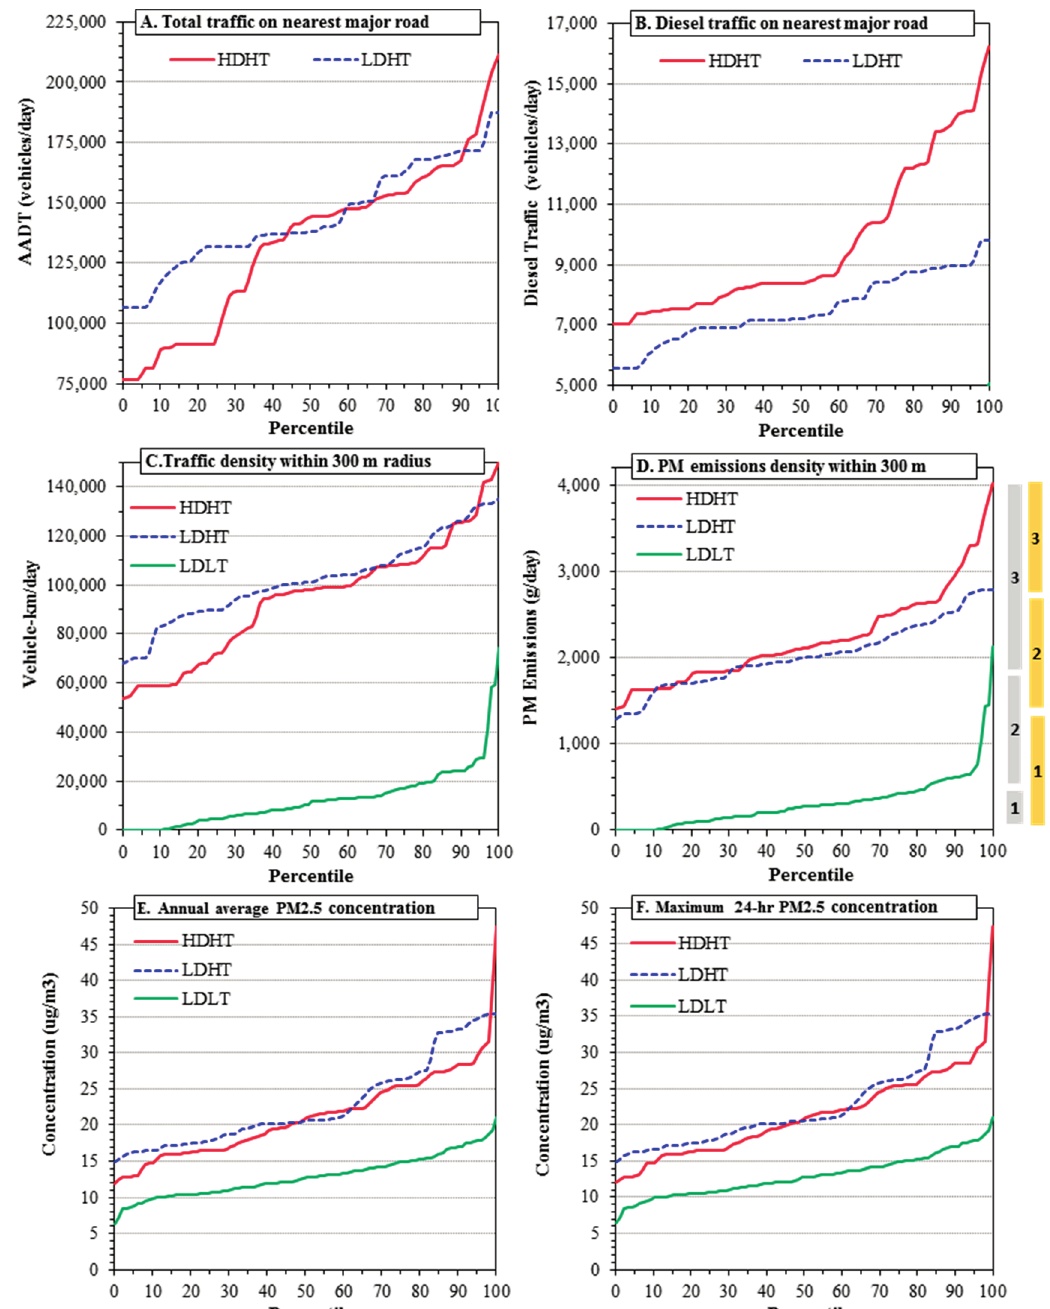
Figure 3. Distributions of selected exposure metrics coded by home group (HDHT = high diesel/high traffic; LDHT = low diesel/high traffic; LDLT = low diesel/low traffic). ( A ) Total traffic volume on major roads nearest home; ( B ) Diesel traffic volume on major ( D ) PM 2.5 emissions density for roads within 300 m of home; ( E ) Annual average PM 2.5 concentrations due to on-road emissions; ( F ) Maximum 24-h average PM 2.5 concentrations due to on-road emissions. Panel D depicts differences between tertiles (in grey) and thirds (in